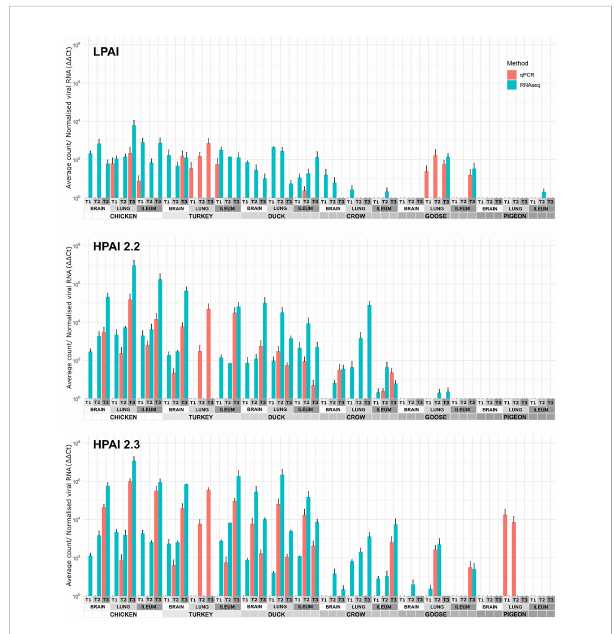
FIGURE 1 Expression of viral genes after challenge with standard error bars. Expression determined by two methods, RT-qPCR of viral genes and viral counts from RNA-seq data. Only RT-qPCR data is available for turkey lung samples. For treatment group sample sizes see Supplementary File